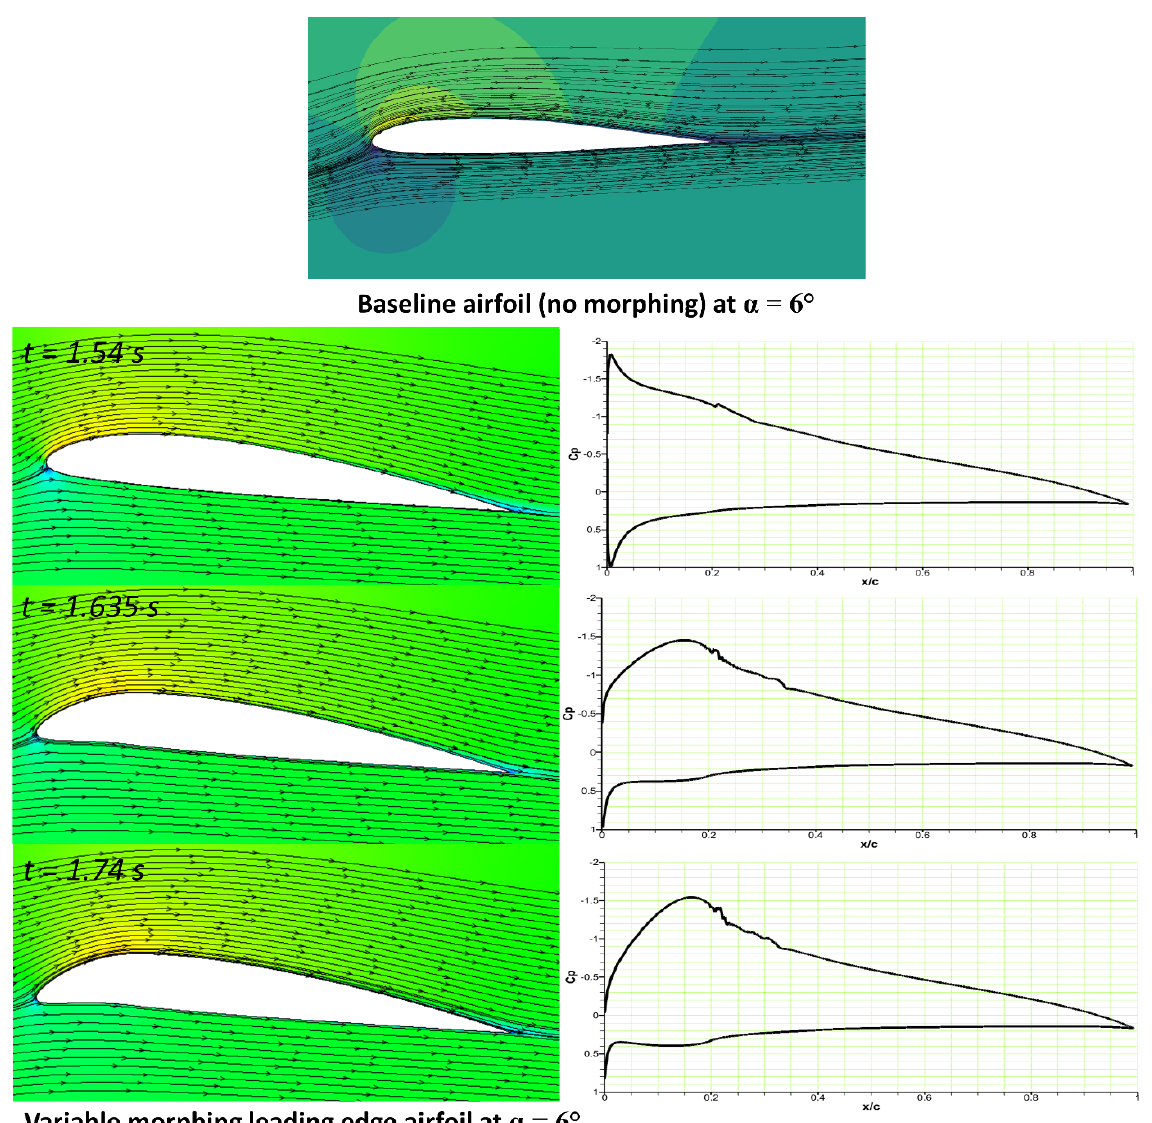
Figure 12. Streamline velocity contours at different time steps on a variable morphing leading edge and the Cp distribution at a 6° angle of attack.